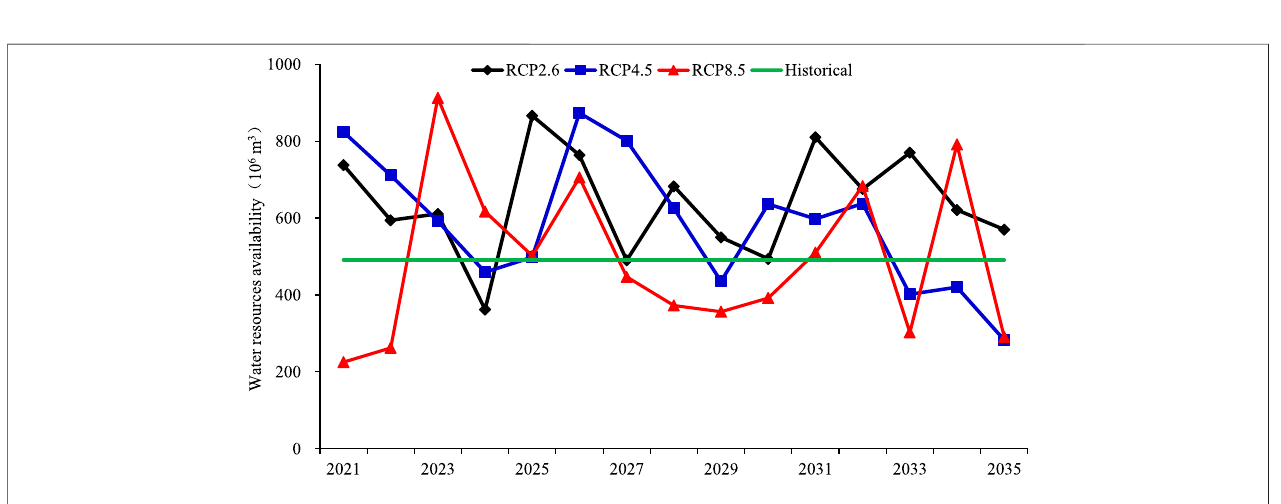
FIGURE 13 | The annual average water availability under different